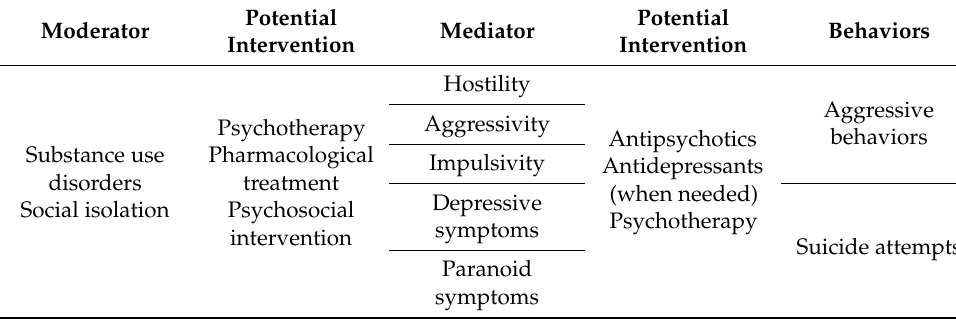
Table 4. Management of substance use disorders and risk of suicide in PHPs for